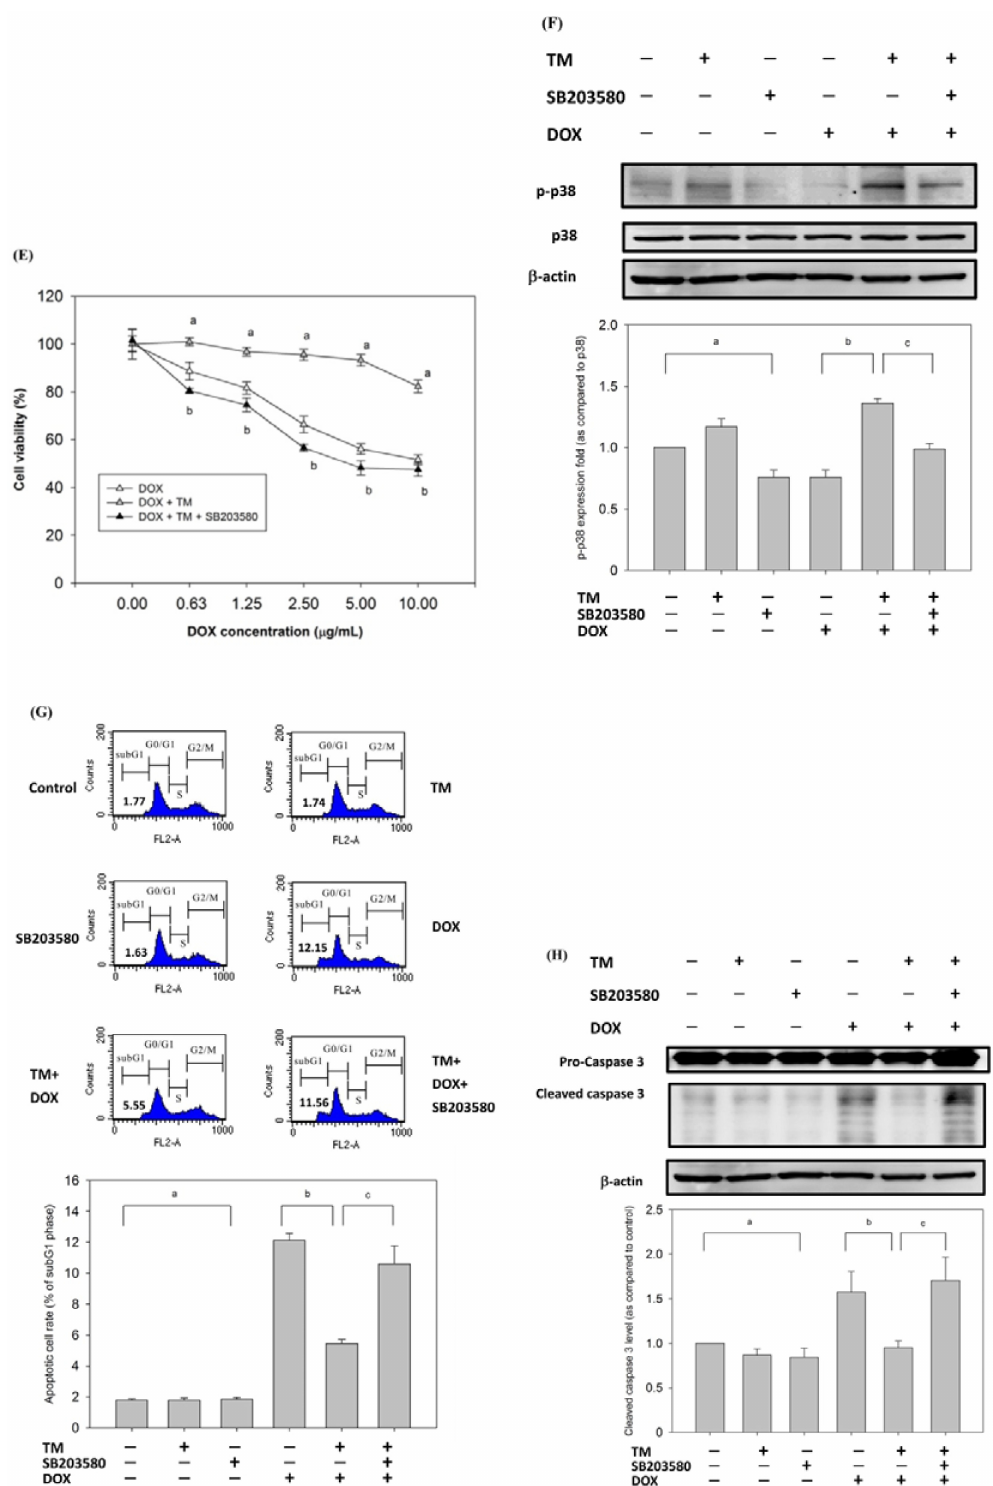
Figure 3. E ff ect of copretreatment with celecoxib or SB203580 on cell toxicity induced by DOX in tunicamycin-treated HepG2 cells. HepG2 cells were pretreated with 1.5 µ M TM for 8 h in the presence or absence of celecoxib (50 µ M) and then exposed to DOX (10 µ g / mL) for 24 h. ( A ) MTT assay showed the cell viability. Data are expressed as the mean ± SD for three independent experiments. a, p <